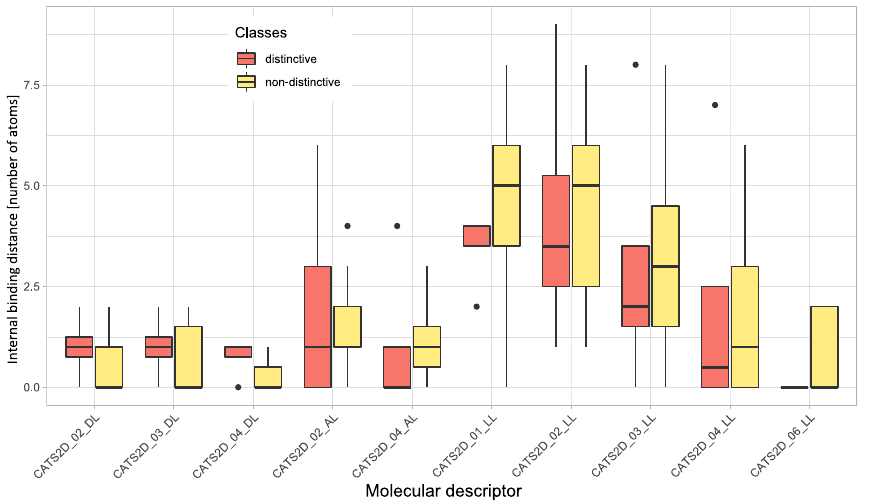
Figure 4. Results of the exploration of differences between distinctive and non-distinctive odors with respect to chemically Advanced Template Search (CATS) 2D molecular descriptors. The boxplots of the top ten CATS2D variables used in random forests and bagged classification and regression tree models. The boxes have been constructed using the minimum, quartiles, median (solid line within the box), and maximum. The whiskers add 1.5 times the inter-quartile range (IQR) to the 75th percentile or subtract 1.5 times the IQR from the 25th percentile. The figure has been created using the R software package (version 3.6.1 for Windows; https:// CRAN.R- proje ct. org/ 40 ) and the R library “ggplot2” (https:// cran.r- proje ct. org/ packa ge= ggplo t2 71 ). ( L lipophilic, A acceptor, D donor, N negatively charged, P positively